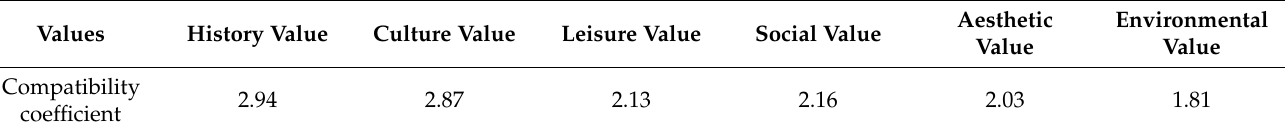
Table 4. Compatibility coefficient in redevelopment